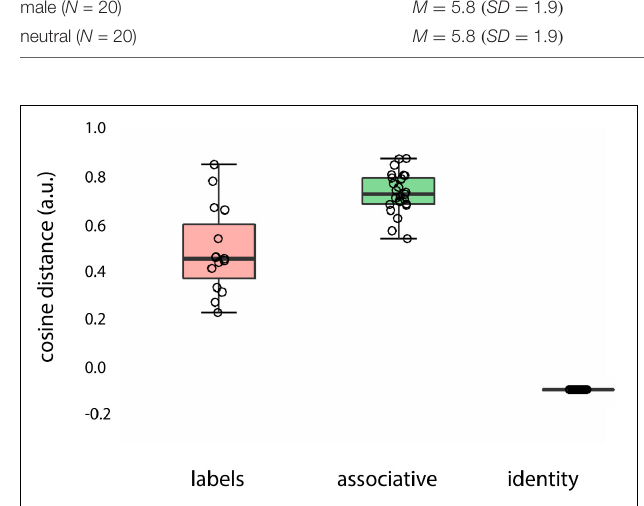
FIGURE 3 | Semantic distance between prime words (labels, associations, and identity words) and target concept introduced by the face (“female”/“male”) color-coded for type of prime word: red, labels (“father”/“daughter”); green, associations (“beard”/“skirt”); black, identity words (“man”/“woman”).